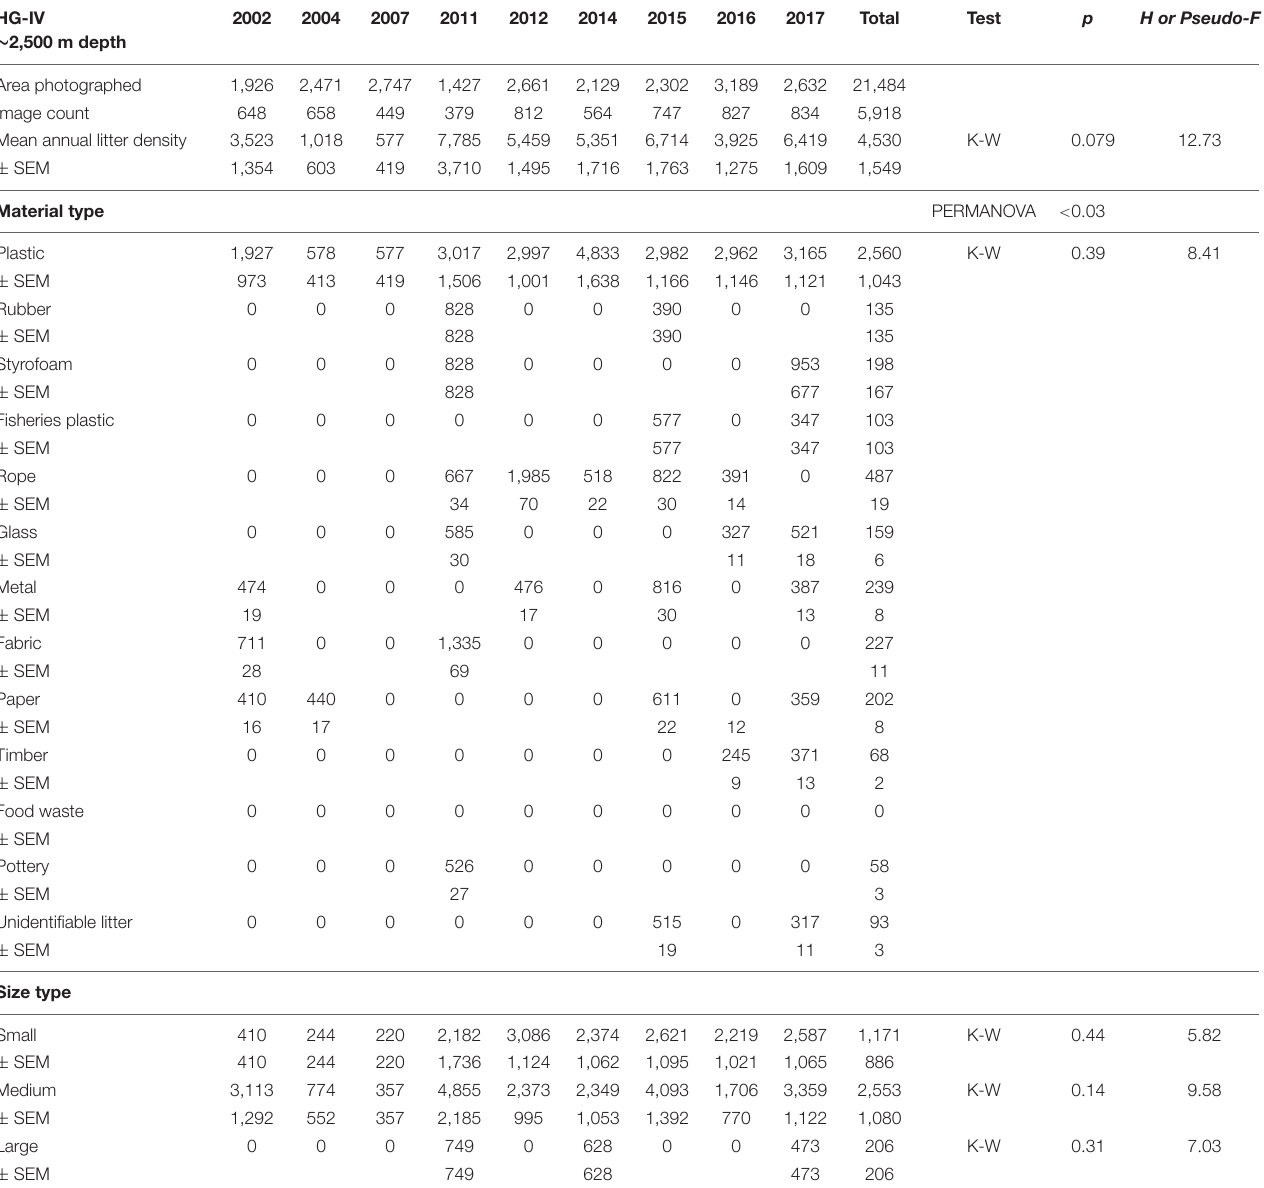
TABLE 4 | Summary of the area covered (m 2 ), mean annual litter densities (items km − 2 ), material and size composition at HAUSGARTEN station HG-IV. HG-IV ∼ 2,500 m